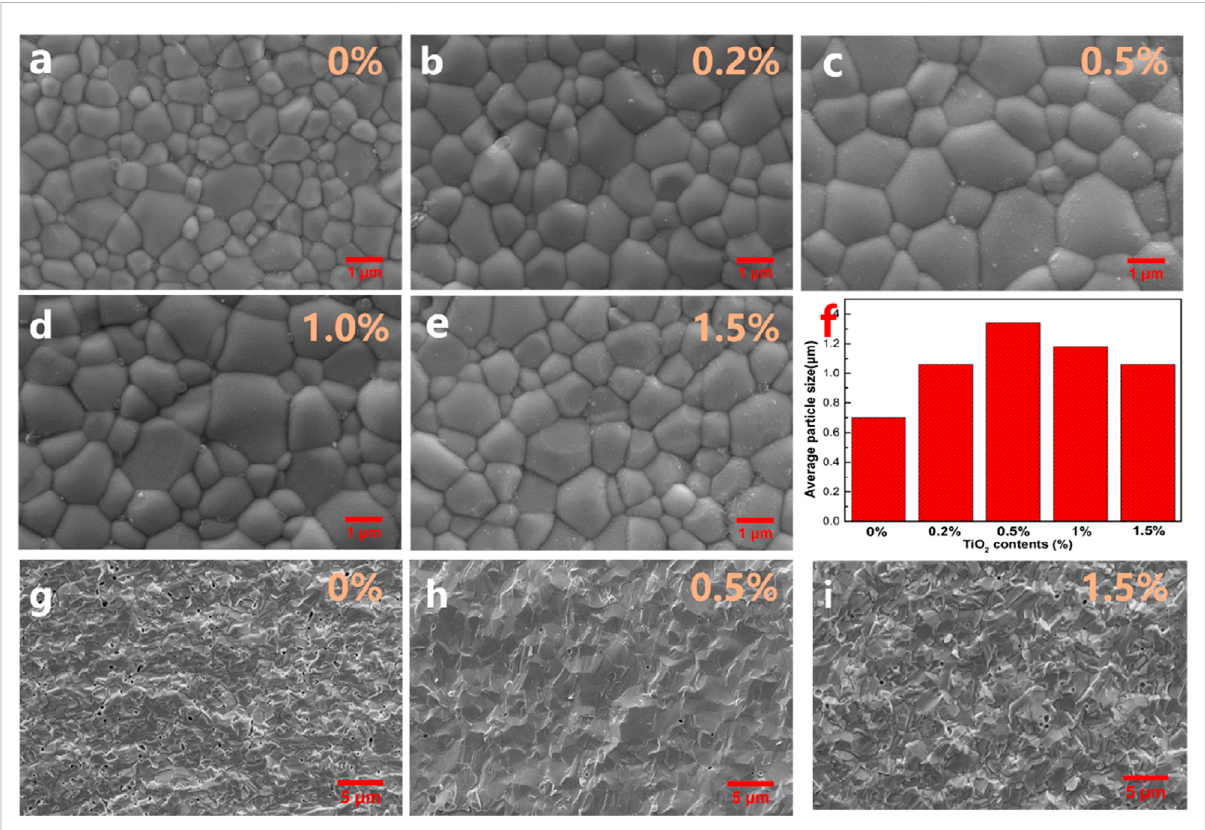
FIGURE 2 (A – E) ThesurfaceSEMimagesofSDC-xT(x=0,0.2,0.5,1and1.5)sinteredat1,400 ° C. (F) TheaveragedparticlesizesforSDC-xT(x=0,0.2,0.5, 1 and 1.5). (G – I) The cross-sectional SEM images of SDC-xT (x = 0, 0.5 and